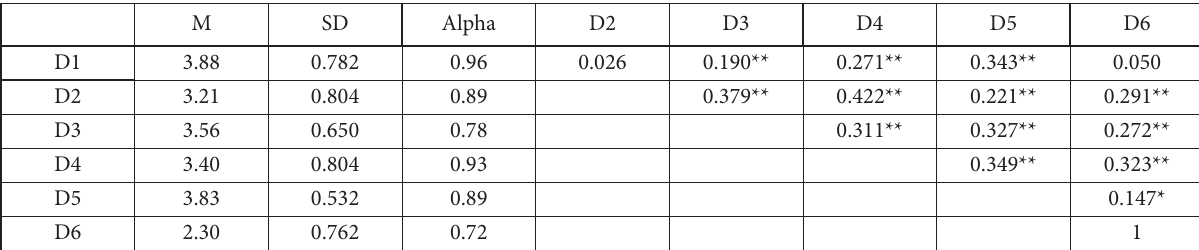
Table 3. Mean, standard deviation, Cronbach’s Alpha reliability and correlation